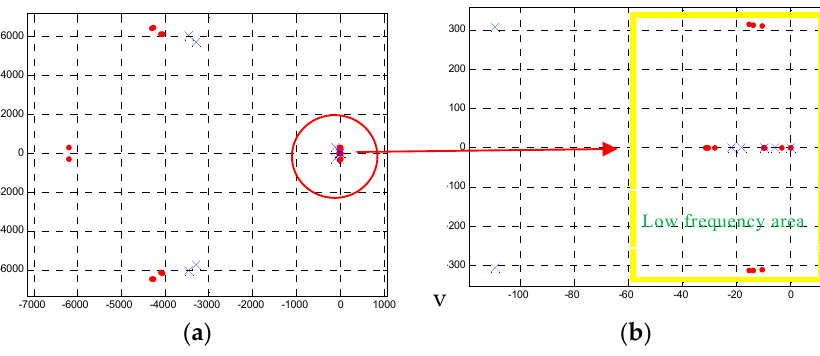
Figure 9. ( a ) The characteristic root contrast diagram of the proposed comprehensive control strategy and the conventional droop control strategy; ( b ) Part of the A graph is magnified.